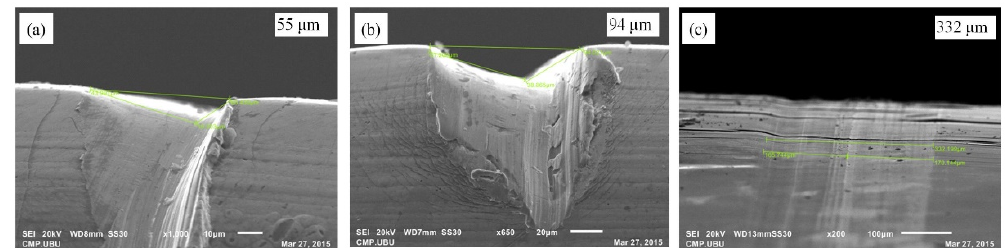
Figure 9. Shape characteristic measured by SEM of ( a ) 55 µm, ( b ) 94 µm, ( c ) 332 µm scratch.